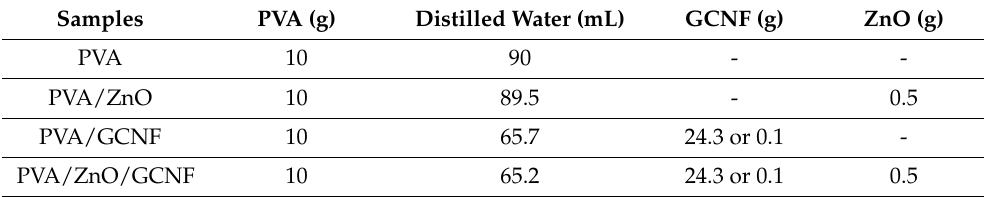
Table 1. The ratio of PVA powders, nanofillers (GCNF and ZnO nanoparticles), and distilled water.